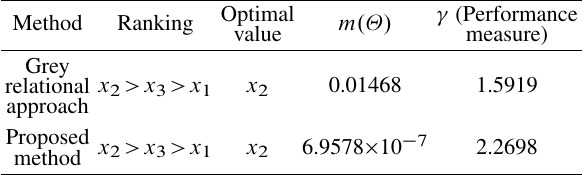
Table 10 Comparison of different methods in Example 4. Method Ranking Optimal